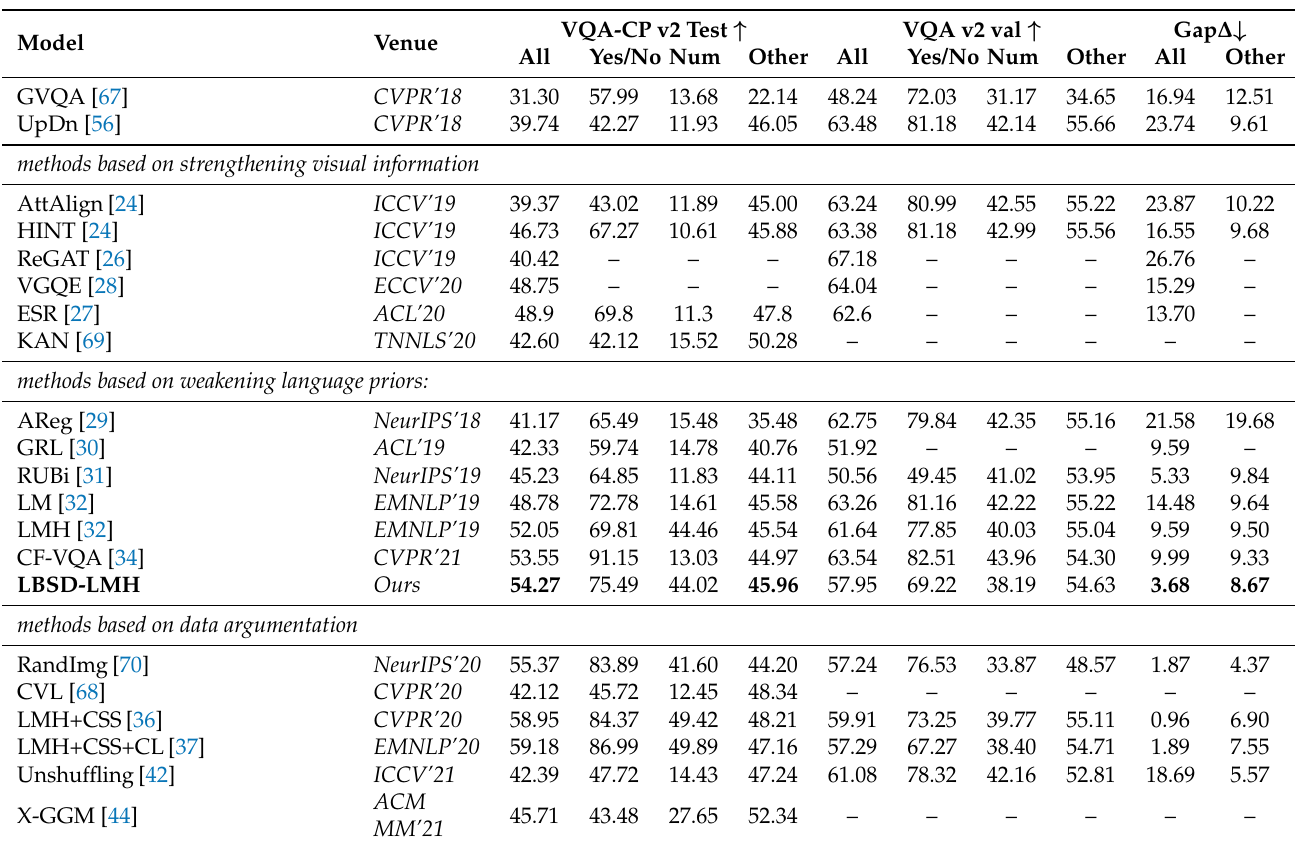
Table 6. Performance comparison (Accuracies (%)) on the VQA-CP v2 test set and the VQA v2 val set of state-of-the-art models. The gap means the performance difference between VQA v2 and VQA-CP